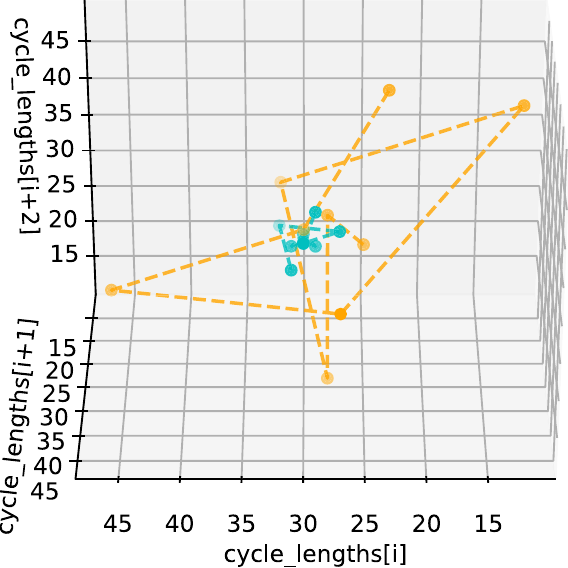
Fig. 2 Time series embedding for cycle length (one user, across groups). We sample one consistently highly variable and one consistently not highly variable user, each with the median number of cycles (11), from the user cohort and plot each set of three consecutive cycles on the x , y , and z axes, respectively. This allows us to visualize how much a user ’ s cycle lengths change throughout their entire cycle tracking history — we would expect that a not consistently highly variable user would have points that cluster closer together in space. We see that the consistently not highly variable (teal) user occupies a small region, while the consistently highly variable (orange) user ’ s points move through the space. This indicates that the teal user ’ s cycle lengths are consistently very similar to one another, whereas the orange user experiences more consistent fl uctuation in cycle lengths. Thus, we see that separating users into groups on the basis of median CLD identi fi es those who are more and less consistently highly variable.